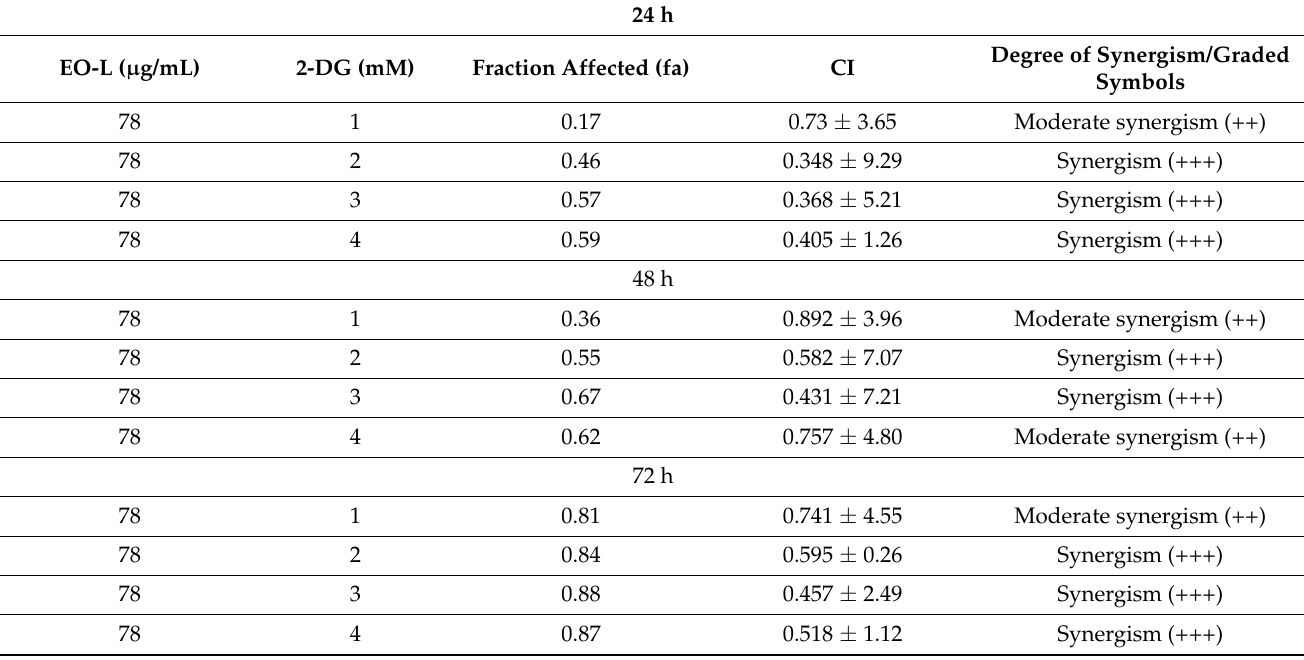
Table 1. Combination index (CI) values of EOL+2DG treatments at 24, 48 and 72 h. 24